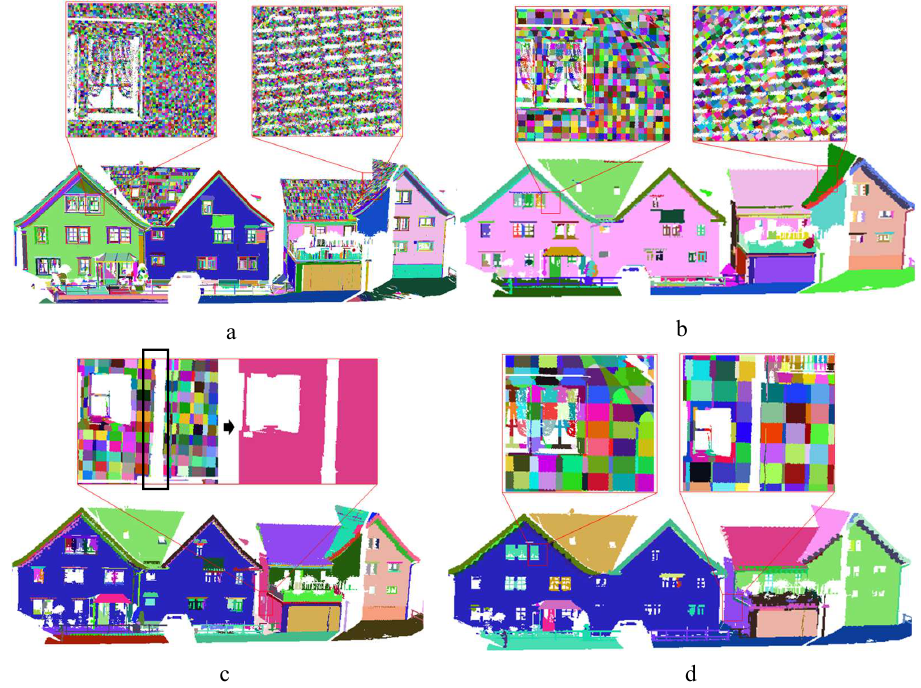
Figure 14. Segmentation results and partial voxelization results of different sizes of d I . ( a ) experiment results when d I = 0.03, cost time 81.5 s, ( b ) experiment results when d I = 0.1, cost time 7.8 s, ( c ) experiment results when d I = 0.15, cost time 7.0 s, and ( d ) experiment results when d I = 0.3, cost time 5.8 s.